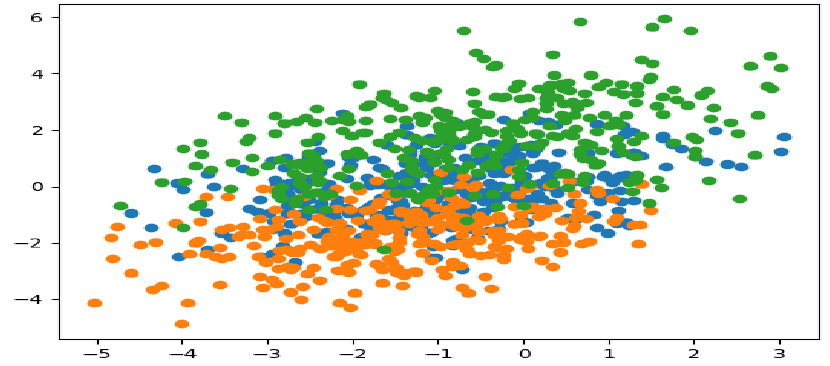
Figure 4. Simulated results for three clusters showing states of the sensor with 6 features.